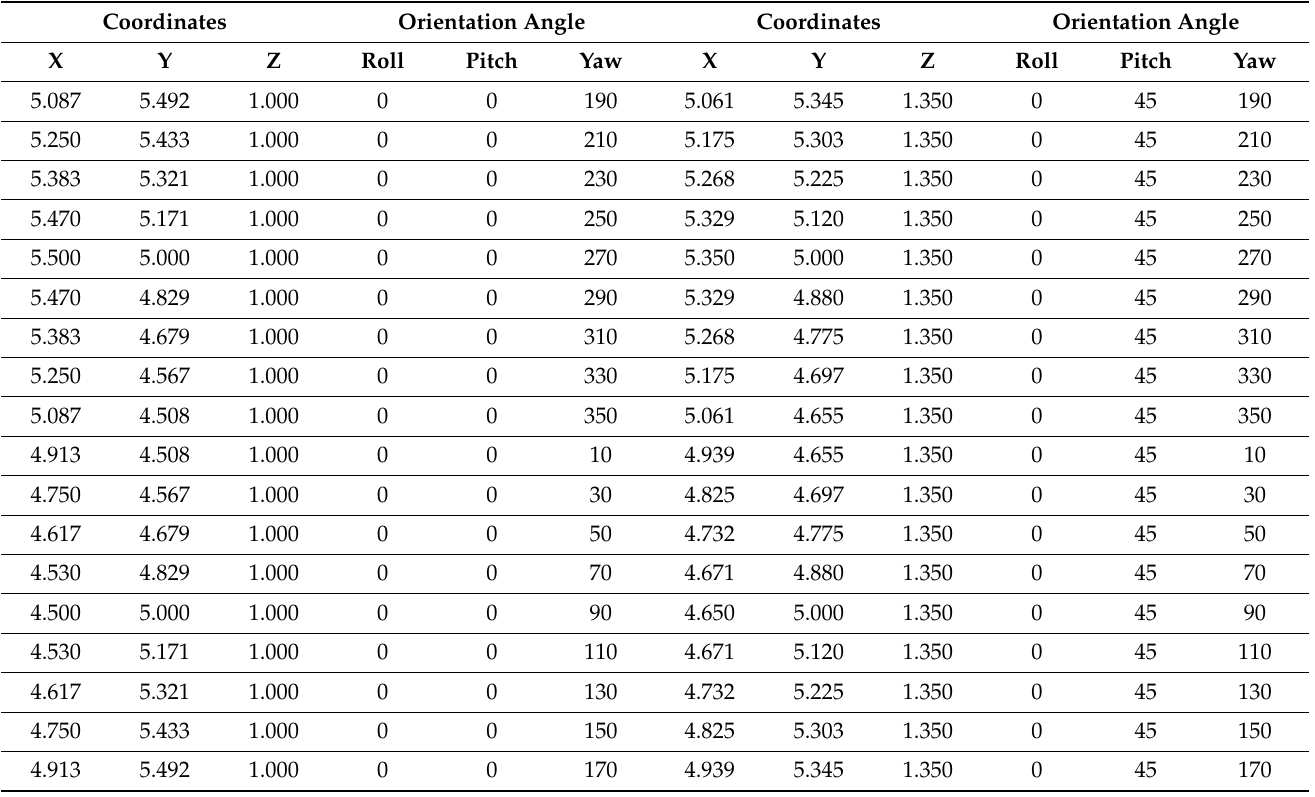
Table 1. Coordinates from the arbitrated